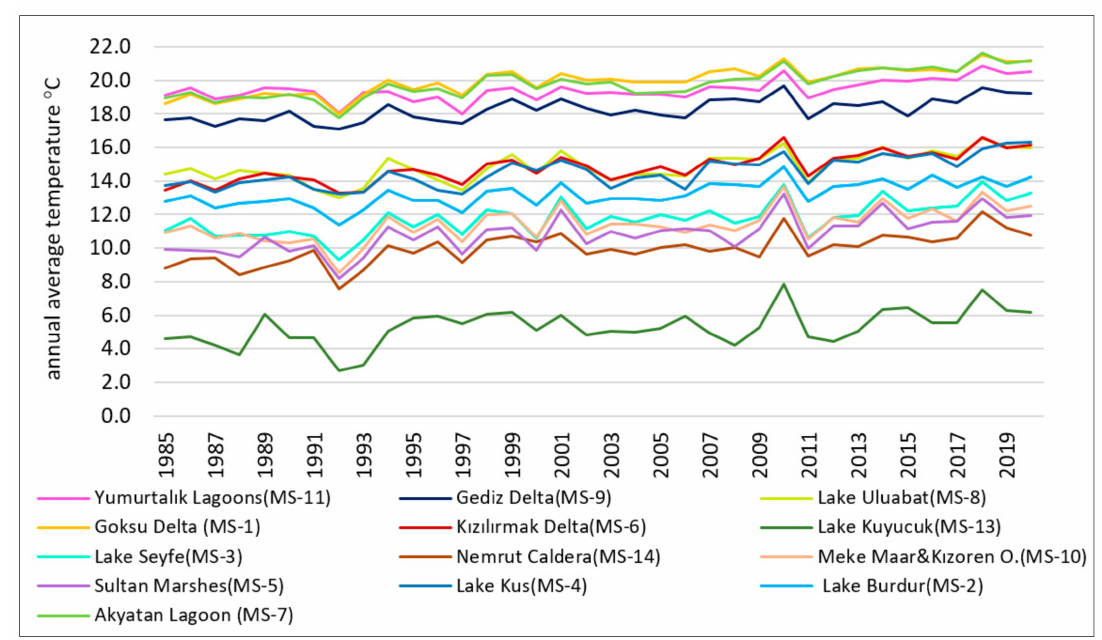
Figure 2. Long-term annual average temperatures representing the Ramsar Sites of Turkey.